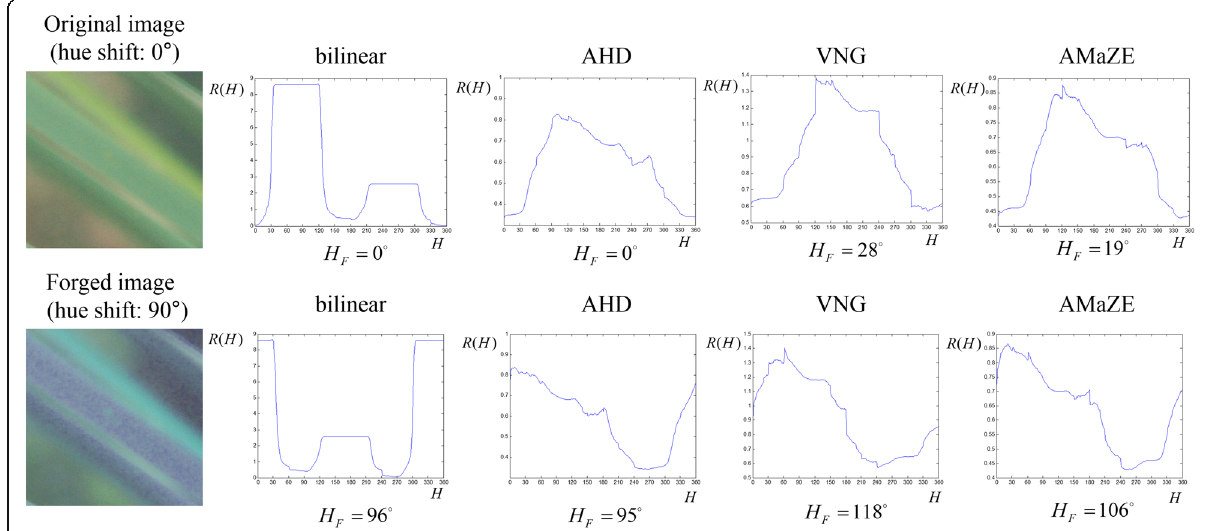
Fig. 3 Estimated shifted angles from various demosaicing methods when hue angles are shifted by 0° and